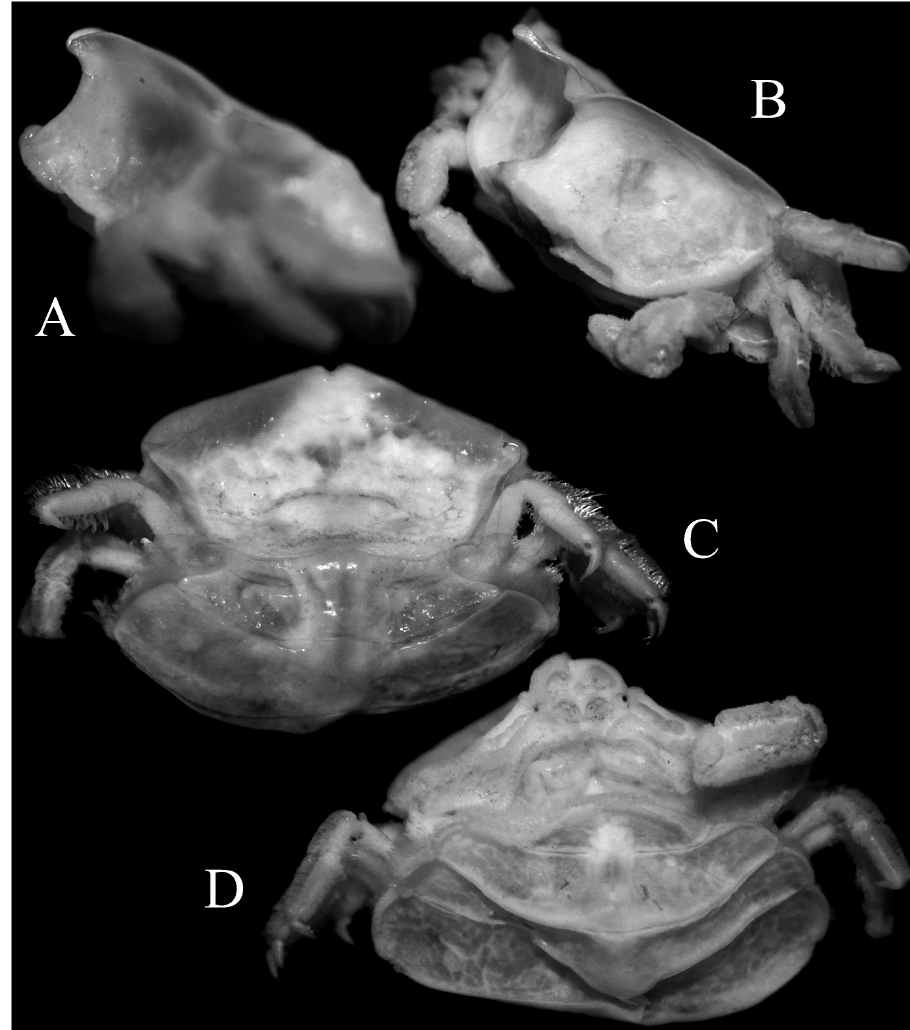
Figure 4. Serenotheres janus sp. n., holotype ♀ (8.9 × 7.9 mm) (USNM). A angled view of cephalothorax B lateral view of cephalothorax C posterior part of dorsal lamellum of carapace and abdominal somites 1–3 D abdominal somites 5, 6 and